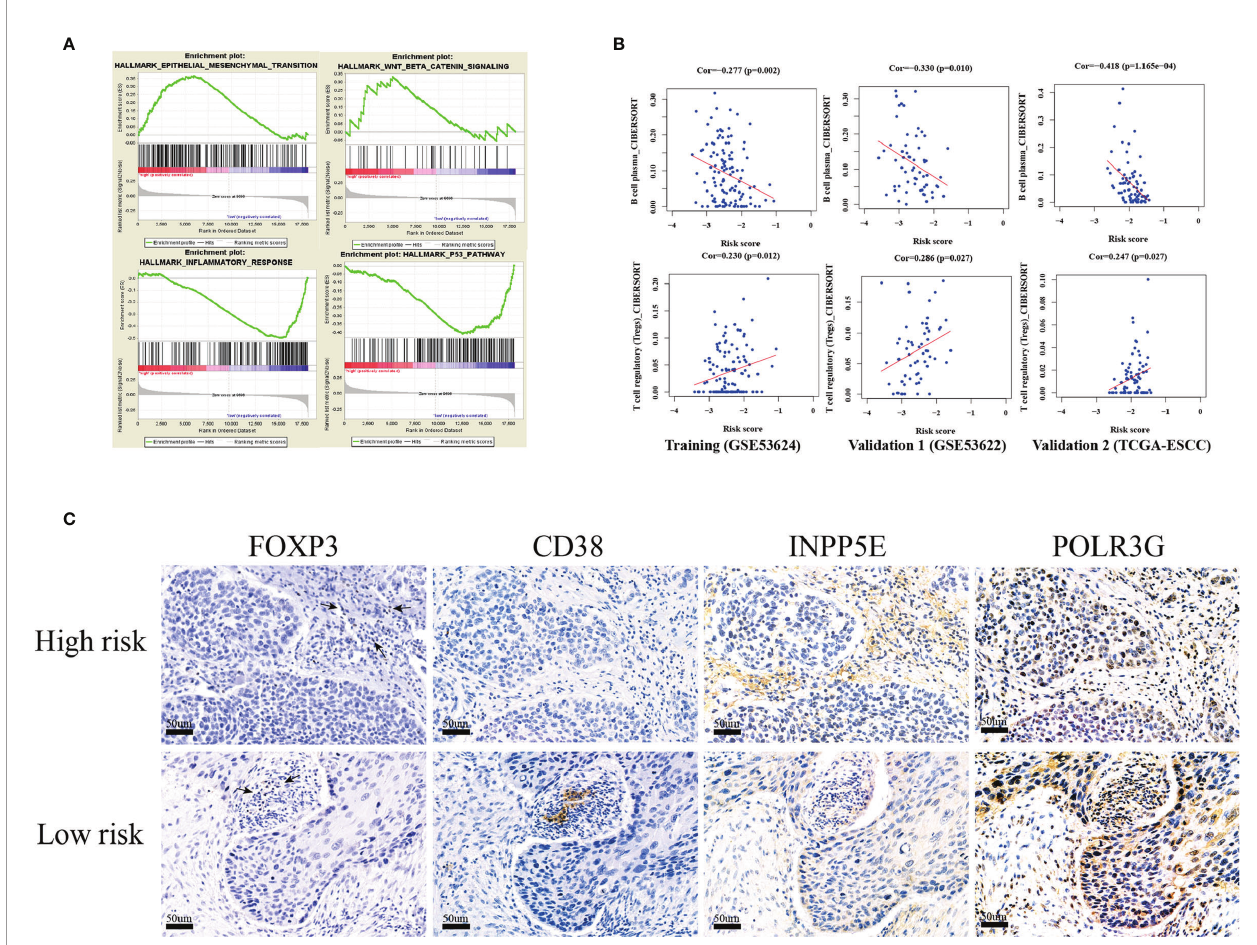
FIGURE 6 | GSEA functional enrichment and immune in fi ltration analysis. (A) The four hallmark pathways were all enriched in the training, validation 1 (GSE53622) and validation 2 (TCGA-ESCC) groups by GSEA functional enrichment analysis. (B) The risk score was positively correlated with Treg cell in fi ltration, and negatively correlated with plasma cells in the training, validation 1 cohort(GSE53622) and validation 2 cohorts (TCGA-ESCC). (C) IHC validation of three-gene metabolic-related signatures (INPP5E,CD38 and POLR3G) and FOXP3(Treg) in 20 ESCC